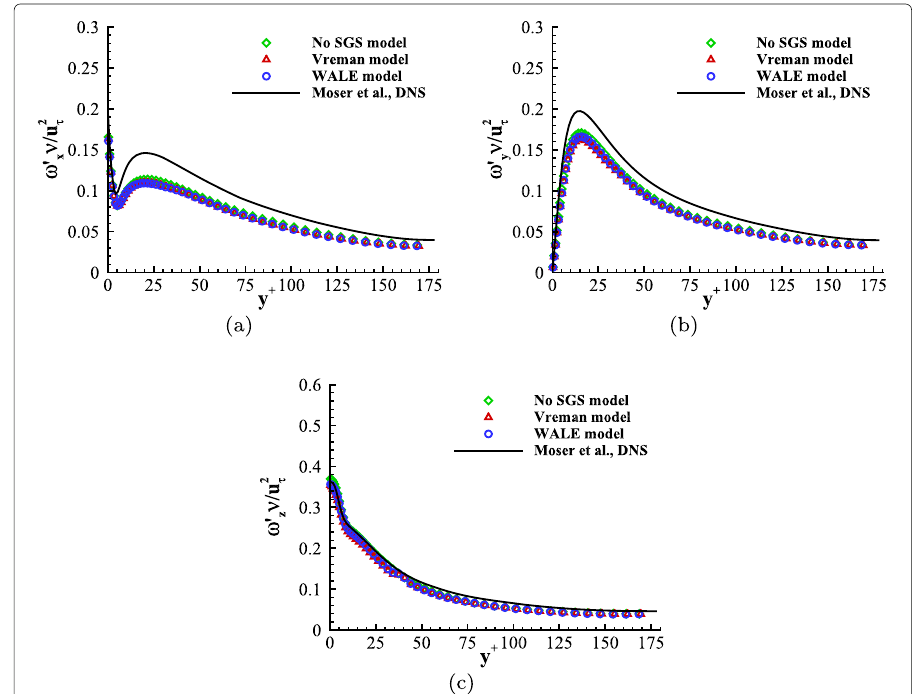
Fig. 6 The r.m.s. vorticity fluctuations for the fully developed turbulent channel flow. a X component, b Y component, c Z component